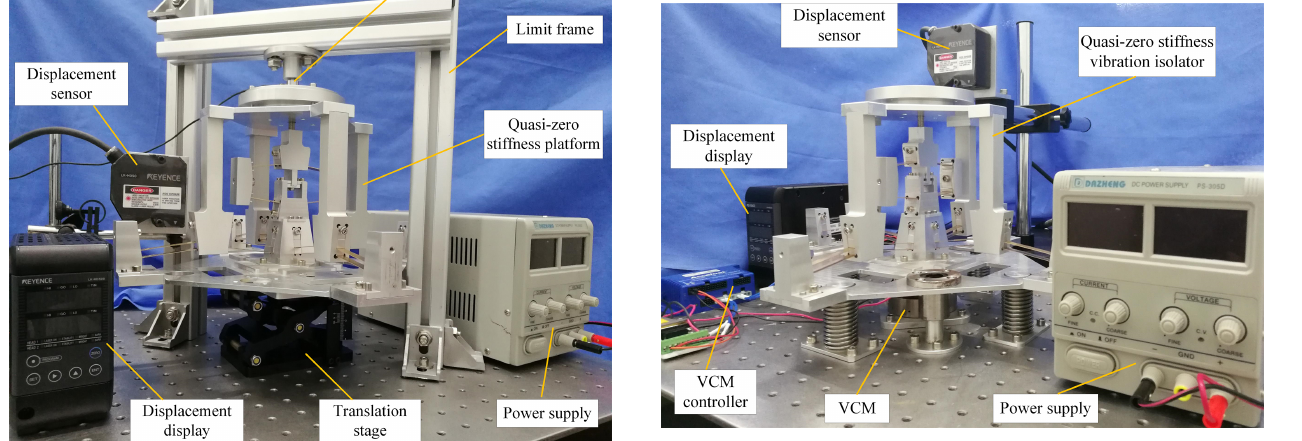
Figure 16. Photograph of the experimental setup of Test 1.